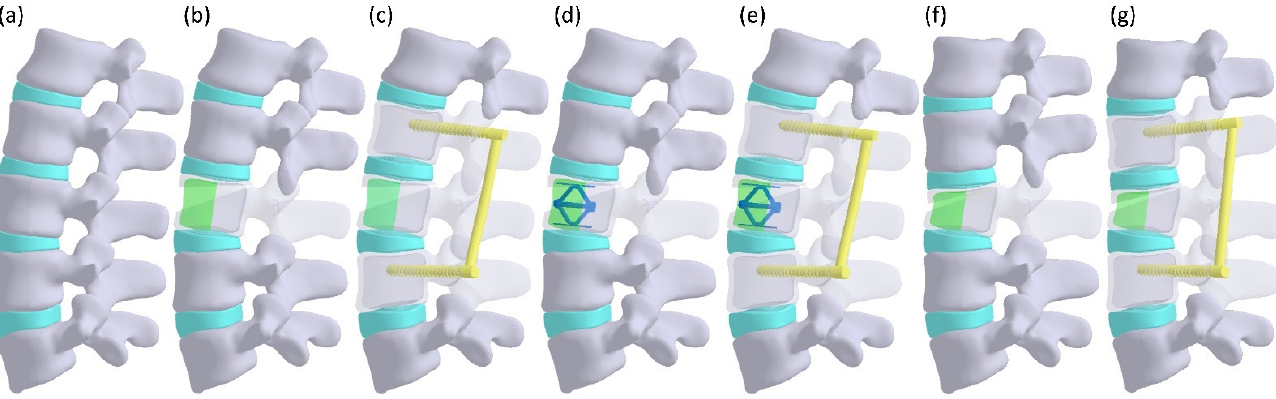
Figure 1. The models used in this study. ( a ) Intact lumbar spine, ( b ) L3 body height completely restored with bone cement (CC), ( c ) bone cement along with PI (CCPI), ( d ) bone cement along with SpineJack (CCSJ), ( e ) bone cement along with SpineJack and PI (CCSJPI), ( f ) L3 incompletely restored with bone cement (ICC), and ( g ) bone cement along with PI (ICCPI).